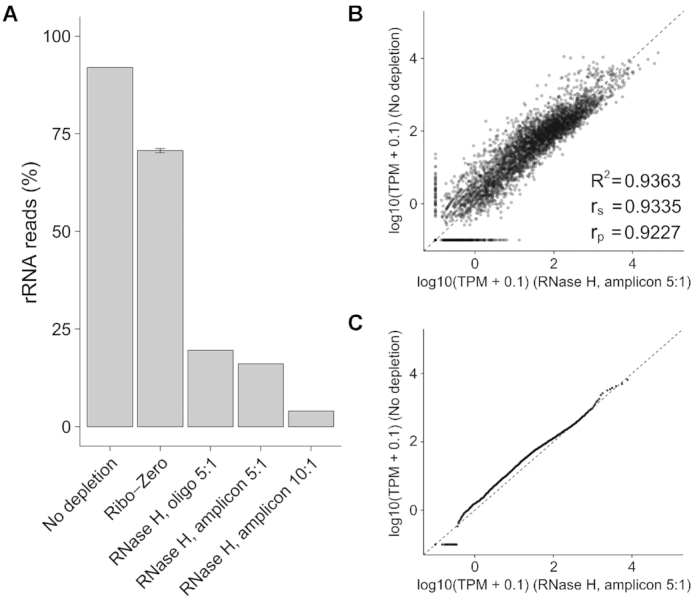
RNase H-based rRNA depletion with amplicons. (A) Proportion of rRNA-aligning reads of total mapped reads (% rRNA reads), for un-depleted, Ribo-Zero depleted and RNase H depleted samples with chemically synthesized oligonucleotides (oligo) or amplicon-based ssDNA (amplicon) probes. (B andC) Scatter plot (B) and Quantile-Quantile (Q-Q) plot (C) for depleted sample using amplicon probes with 5:1 probe-to-RNA ratio and un-depleted sample.